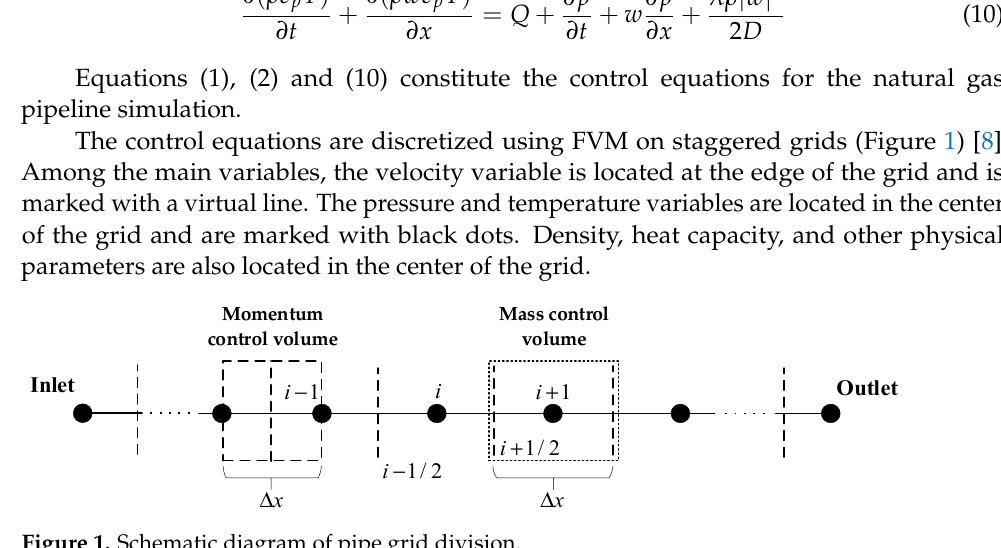
Figure 1. Schematic diagram of pipe grid division.